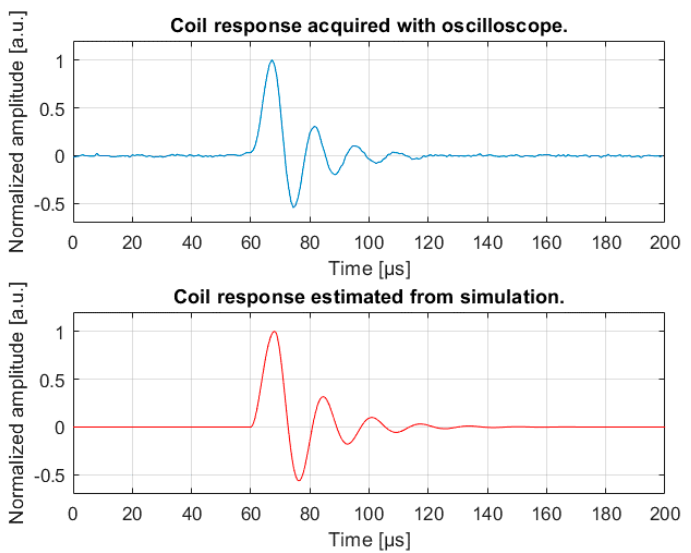
Figure 12. In the upper panel (blue line), the coil response acquired during the tests is shown. In the lower panel (red line), the coil response computed with the simulation is shown.